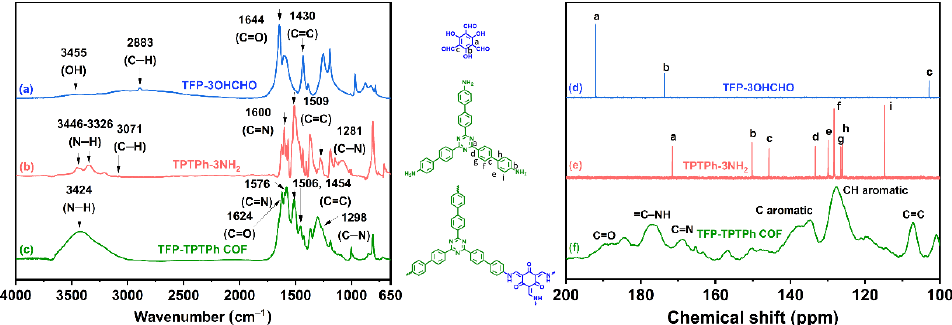
Figure 1. ( a – c ) FTIR spectra of ( a ) TFP-3OHCHO, ( b ) TPTPh-3NH 2 , and ( c ) TFP-TPTPh COF. ( d – f ) 13 C SS-NMR spectra of ( d ) TFP-3OHCHO, ( e ) TPTPh-3NH 2 , and ( f ) TFP-TPTPh